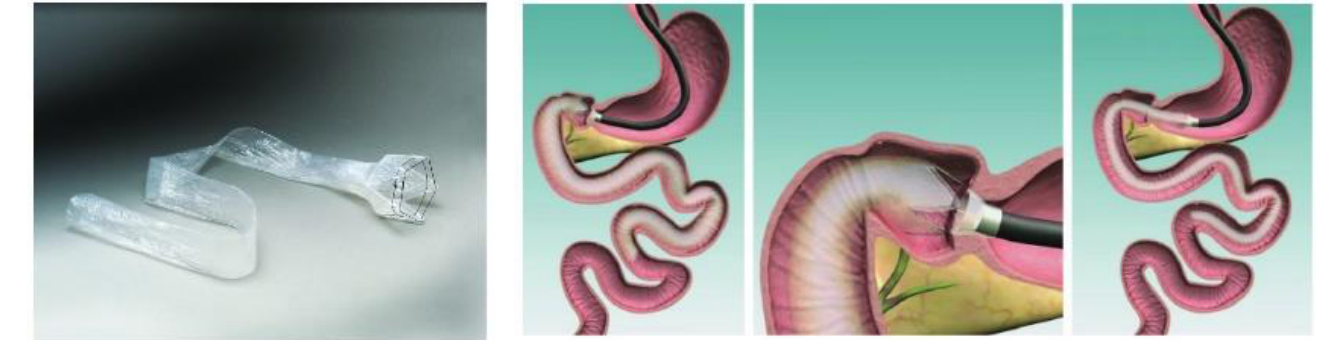
Figure 1. The EndoBarrier device and duodenal implantation (Ruban et al. 2018).